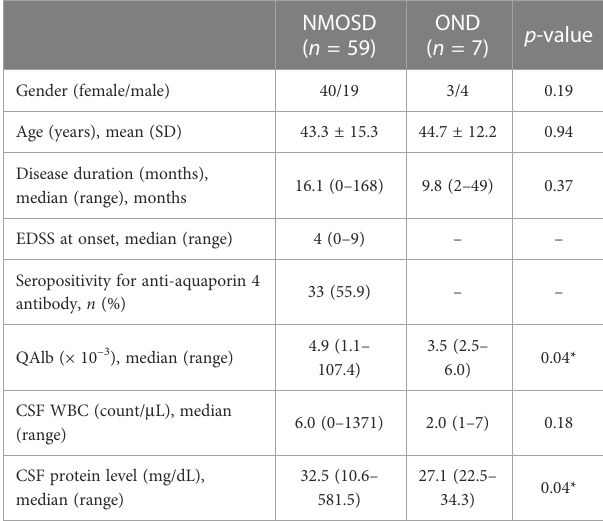
TABLE 1 Demographic data and clinical characteristics of